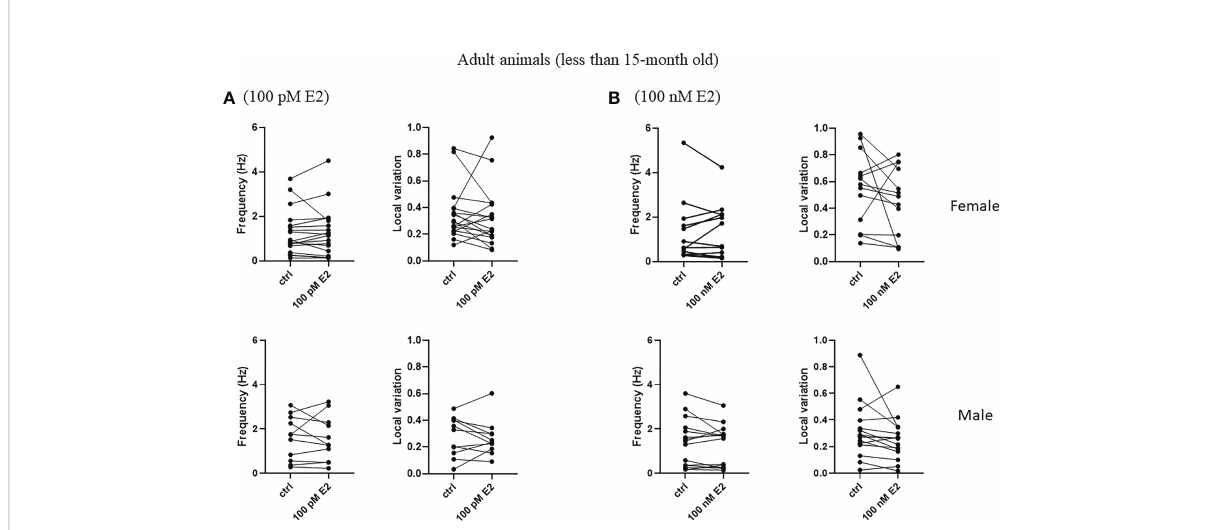
FIGURE 8 Rapid effect of 17 b -estradiol on spontaneous activity of cholinergic interneurons in adult animals. The acute effect of 100 pM or 100 nM 17 b - estradiol on spontaneous activity of cholinergic interneurons are shown in Panels (A, B) ,